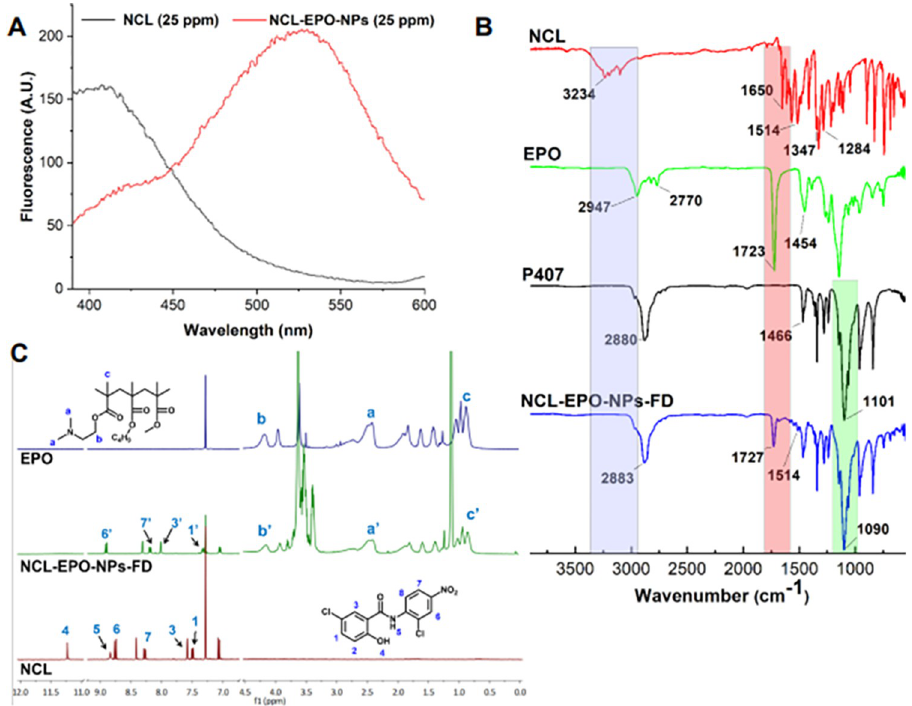
Fig 3. NCL-EPO molecular interaction is maintained in the nanoformulation. P407-stabilized NCL-EPO-NPs with NCL loading of 40% w/w of EPO were either used as an aqueous dispersion or freeze dried to obtain dry powder (NCL-EPO-NPs-FD) for FT-IR and NMR analysis. (A) Spectrofluorometric analysis of NCL hydroalcoholic solution (25 ppm) and aqueous dispersion of NCL-EPO-NPs (equivalent to 25 ppm NCL) showed a significant red shift in the case of NCL-EPO-NPs indicating strong molecular interaction between NCL and EPO in the NPs. (B) FT-IR spectroscopic analysis of NCL-EPO-NPs-FD showed absence of–OH and–NH stretching vibrations of NCL and shifts in the C = O stretching vibrations of EPO indicating the retention of molecular interaction between NCL and EPO in the NPs. (C) NMR spectroscopic analysis of NCL-EPO-NPs-FD showed disappearance of protons corresponding to– OH and–NH functional groups in NCL indicating retention of strong molecular interaction between NCL and EPO in the NPs. FT-IR, Fourier-transform infrared; NCL, niclosamide; NCL-EPO-NP, NCL-loaded EPO NP; NMR, nuclear magnetic resonance; NP,